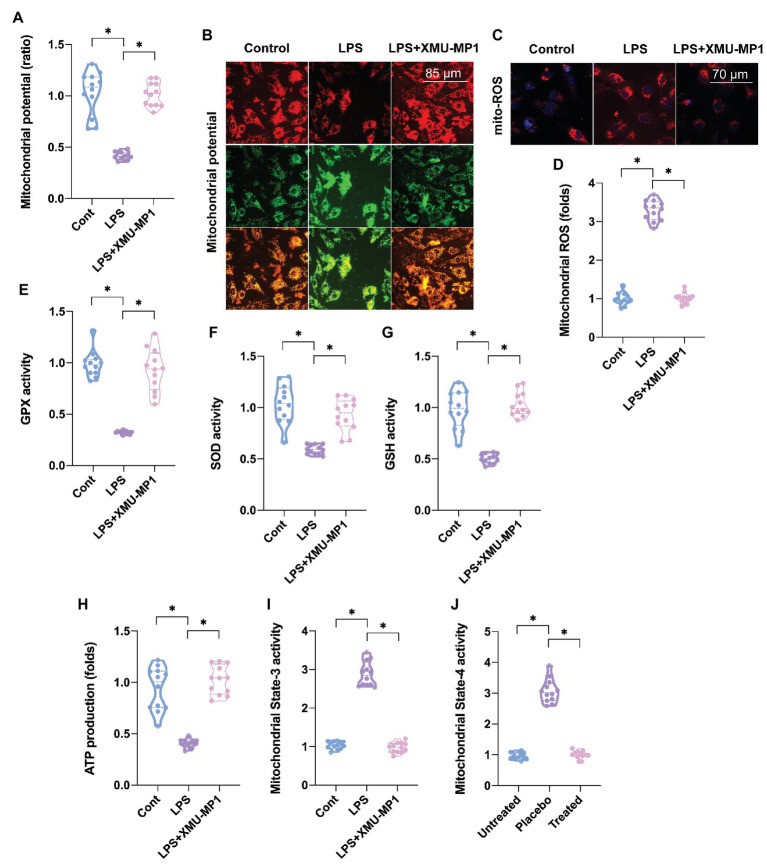
Mst2 mediates mitochondrial dysfunction in LPS-treated H9C2 cardiomyocytes. (A,B) FACS plots and quantitative analysis of JC-1 stained control, LPS-treated, and XMU-MP1 plus LPS-treated H9C2 cells are shown. Mitochondrial membrane potential was determined by evaluating the ratio of red-to-green JC-1 fluorescence intensity (C,D) Immunofluorescence analysis shows Mitosox red [mitochondrial reactive oxygen species (ROS)-sensitive dye] stained control, LPS-treated, and XMU-MP1 plus LPS-treated H9C2 cells. (E–G) ELISA analysis shows the levels of anti-oxidative proteins, namely, GSH, SOD, and GPX in the control, LPS-treated, and XMU-MP1 plus LPS-treated H9C2 cells. (H) The histogram shows ATP levels in the control, LPS-treated, and XMU-MP1 plus LPS-treated H9C2 cells. (I,J) Mitochondrial respiration assay results show the rate of state-3 and state-4 mitochondrial respiration in control, LPS-treated, and XMU-MP1 plus LPS-treated H9C2 cells. LPS treatment was performed for 24 h. H9C2 cells were pre-treated with the Mst2 blocker, XMU-MP1 for 6 h before treatment with LPS treatment. *
p < 0.05.